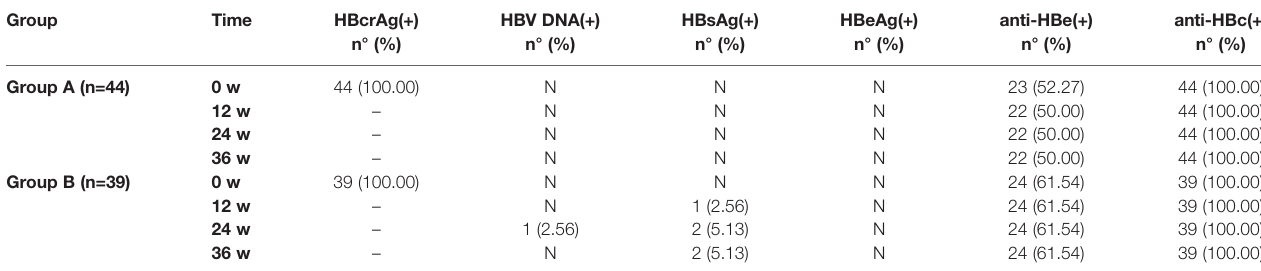
TABLE 3 | Results of serum markers of hepatitis B virus in OBI patients. Group